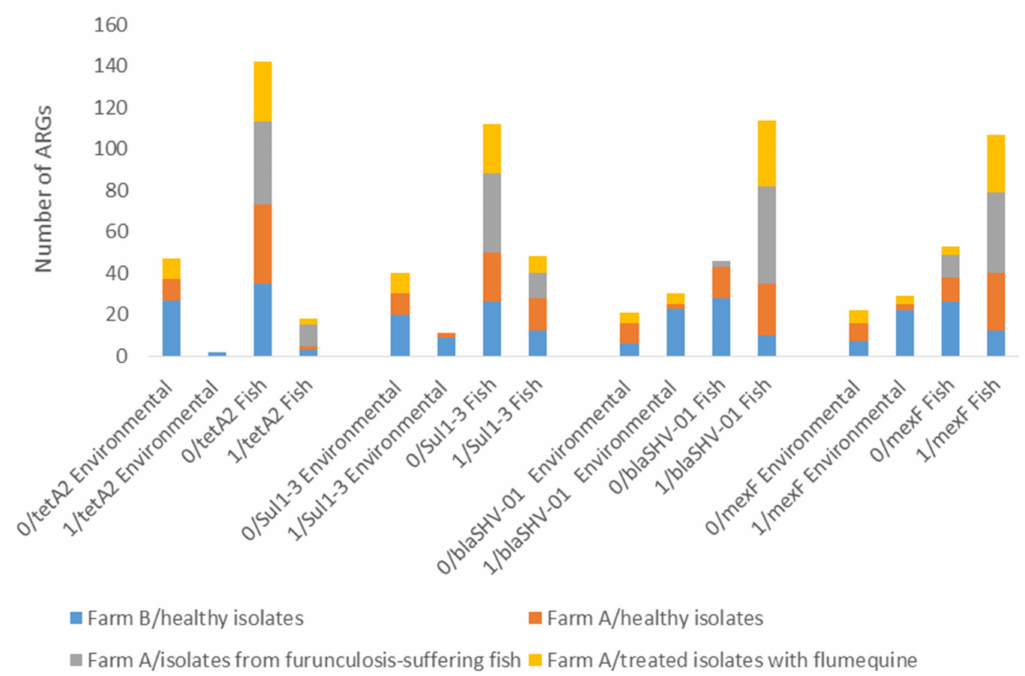
Figure 3. The distribution of antibiotic resistance genes (ARGs) in Aeromonas isolated from environmental and fish samples on fish farms A and B. Aeromonas strains isolated from healthy, furunculosis-suffering and antibiotic-treated fish and their environment. Note: no episode of furunculosis or antibiotic treatment was observed on farm B; 0: ARG has not been detected; 1: ARG has been